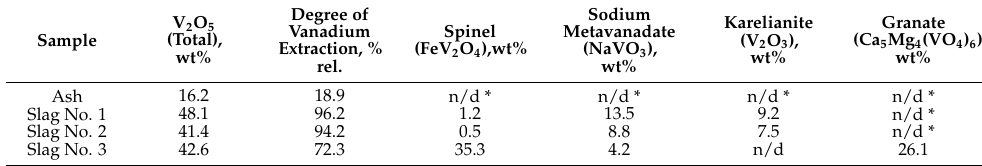
Table 6. The degree of vanadium extraction into the solution, %